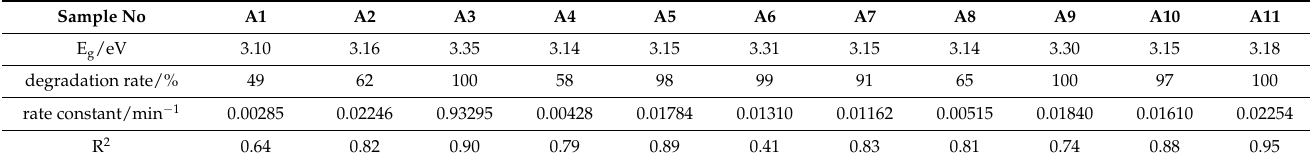
Table 4. Band gap, degradation rate, rate constant and R 2 of the